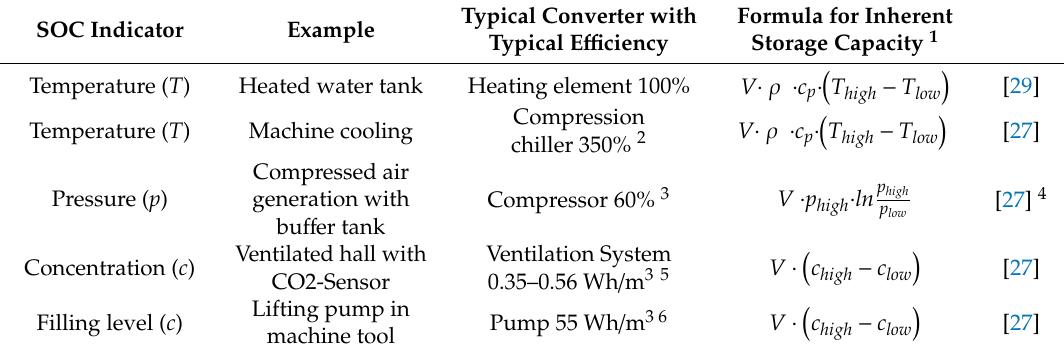
Table 1. Examples for inherent energy storages in production